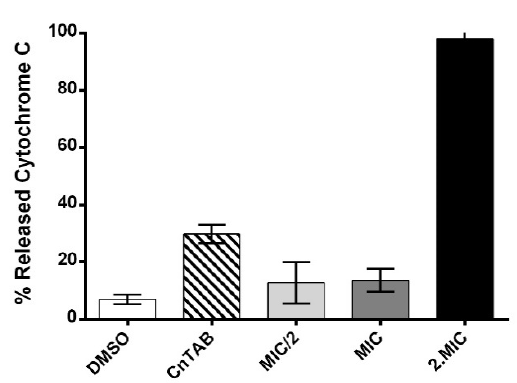
Figure 7. Percentage of cytochrome c that was not associated to the surface of S. aureus cells in the presence of AHR at different concentrations. CnTAB—positive control. Experiments were performed in triplicate. Shown are means with the standard error.